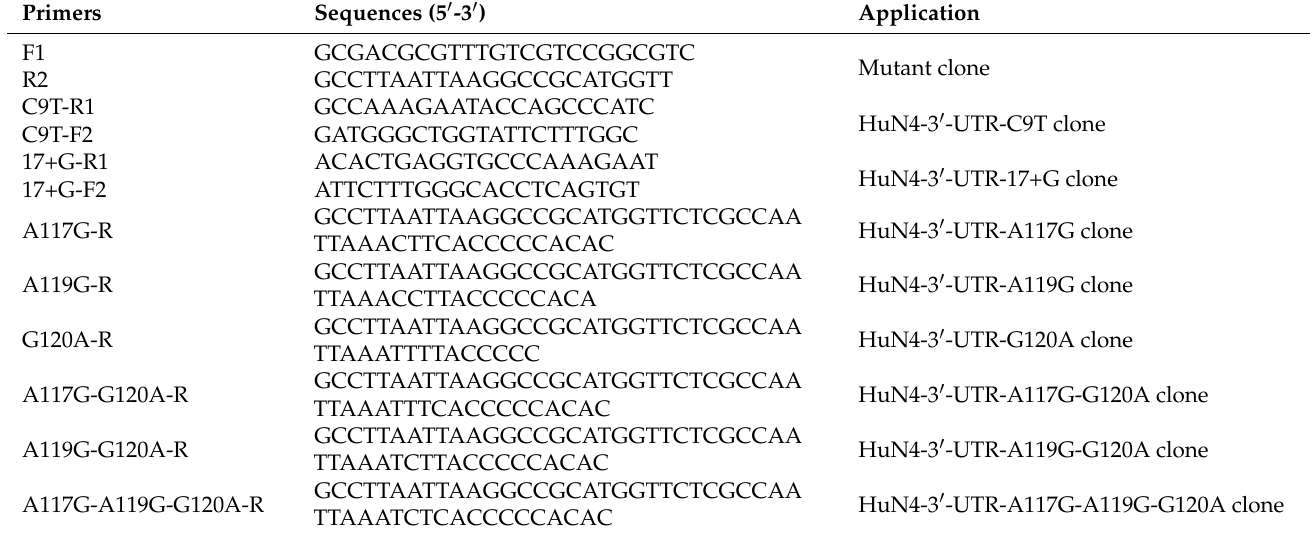
Table 1. Primers used in this